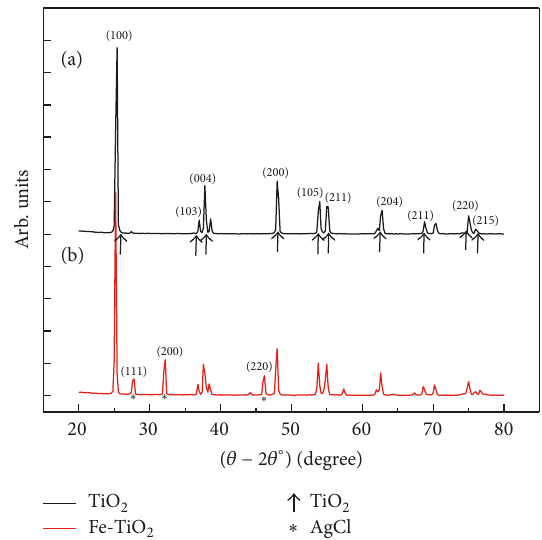
Figure 3: X-ray diffraction pattern of (a) pure TiO 2 and (b) iron doped TiO 2